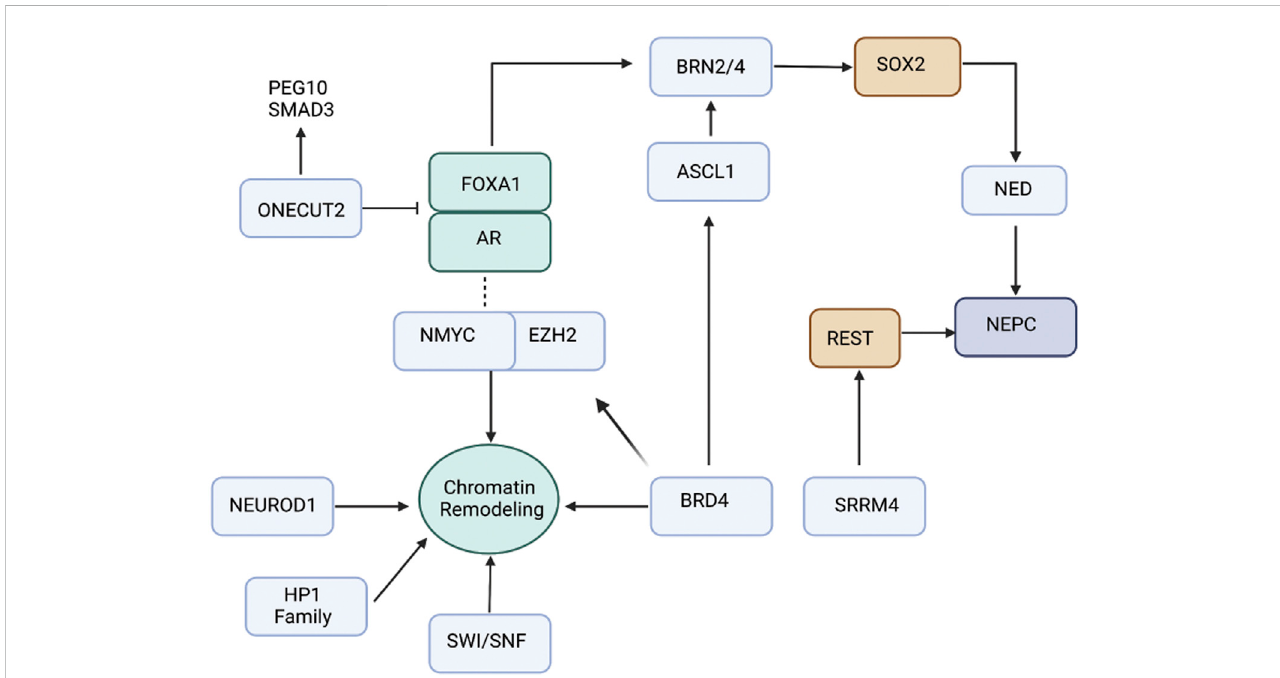
FIGURE 1 Schematic view of the interplay between transcription factors and chromatin regulators driving NEPC. ONECUT2 is a direct repressor of AR signaling, thereby promoting NEPC. ASCL1 is pioneering transcription factor controlling expression of neuronal genes. EZH2 is the histone methyltransferase that is pivotal in driving NEPC. Recent data suggest that association of EZH2 with AR drive reprogramming of AR cistrome that leads to expression of neuronal- associated gene programs. POU-domain TFs BRN2 and BRN4 play critical role in regulating SOX2 driving neuroendocrine differentiation. Several other factors including NEUROD1, BRD4, SWI/SNF and HP1 family drive epigenetic reprograming/chromatin remodeling leading to